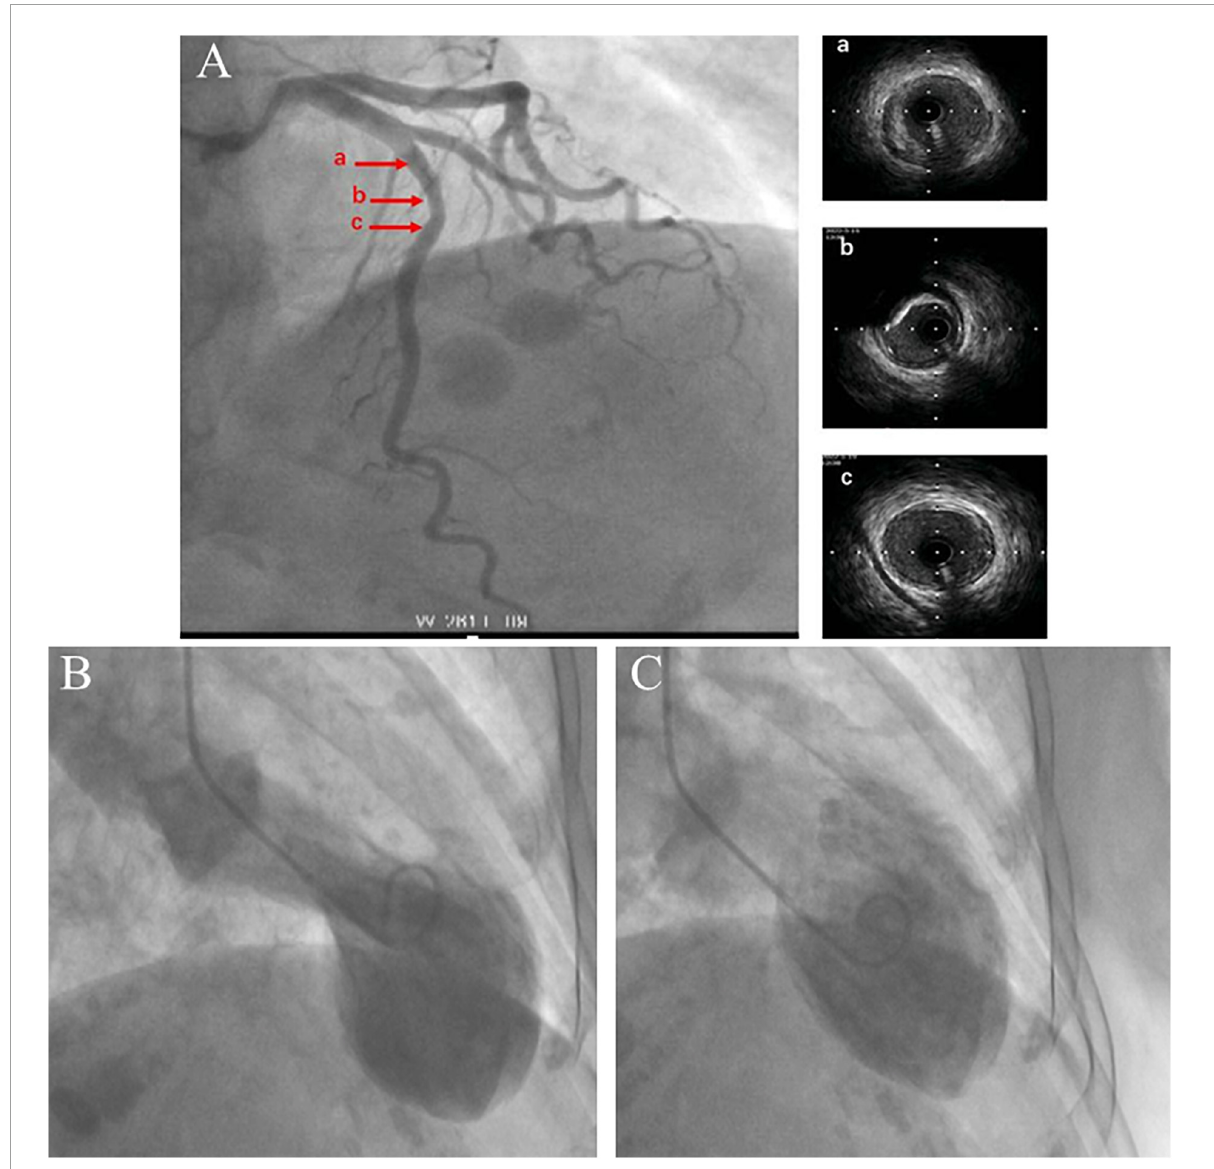
FIGURE3 Coronary angiography and intravascular ultrasound show 30% stenosis of the left anterior descending coronary artery with no plaque rupture or dissecting hematoma. The a, b, and c arrows on the left correspond to the ultrasound positions labeled a–c on the right (A) . Left ventricular angiography shows a takotsubo contractile pattern with apical dyskinesis and basal hyperkinesis (B,C) . (B) Systole. (C) Diastole.